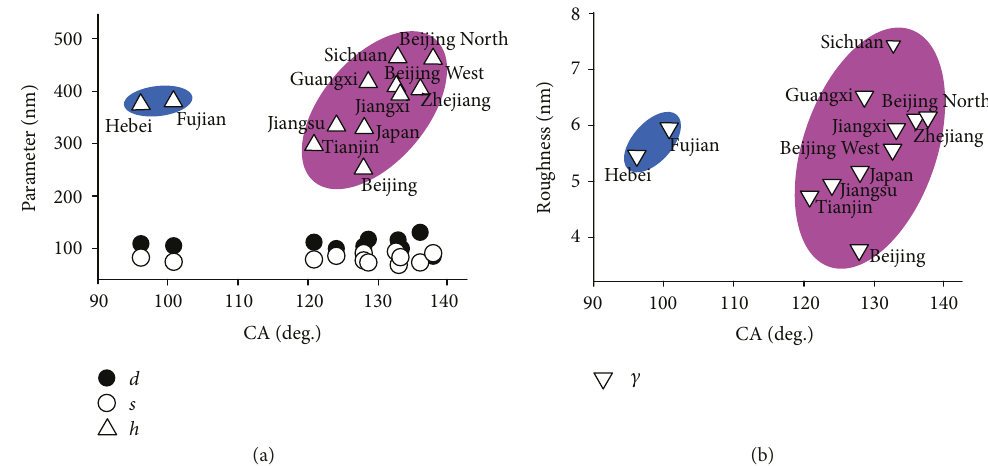
Figure 3: The correlation of contact angle with protrusion parameters on the cicada Cryptotympana atrata wing surfaces. (a). Height of protrusion and (b) roughness of the wing surface as a function of contact angle